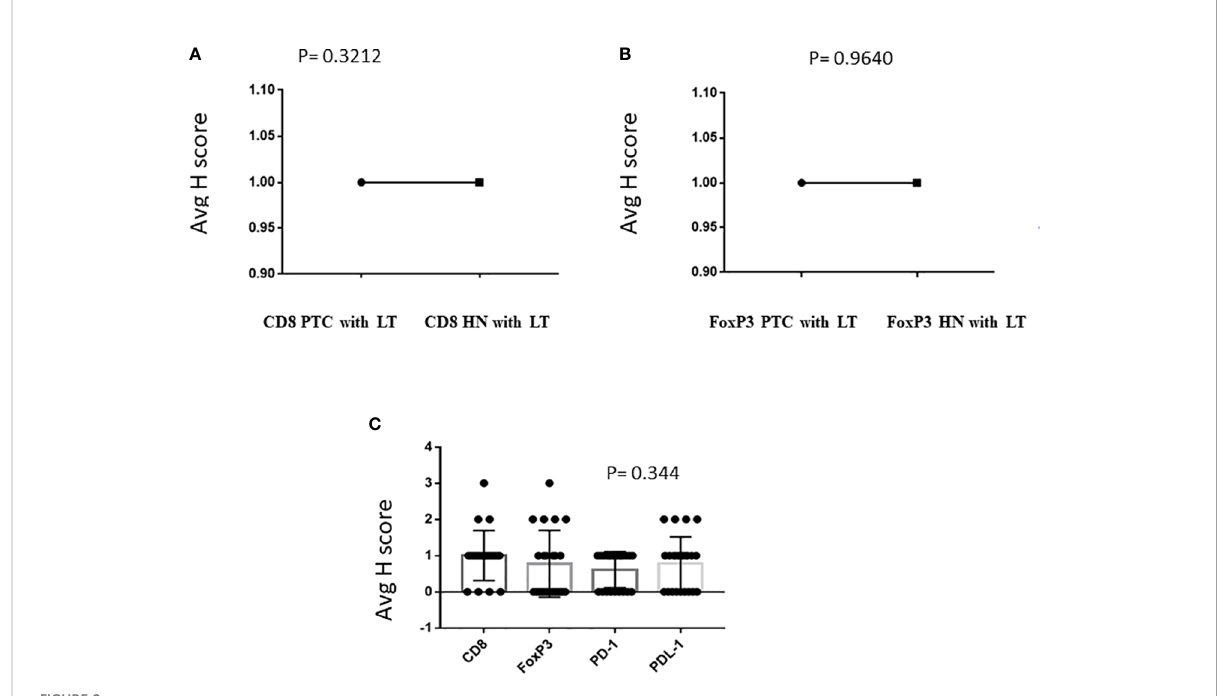
FIGURE 2 (A – C) Relative expression of CD8 and FoxP3 in PTC with